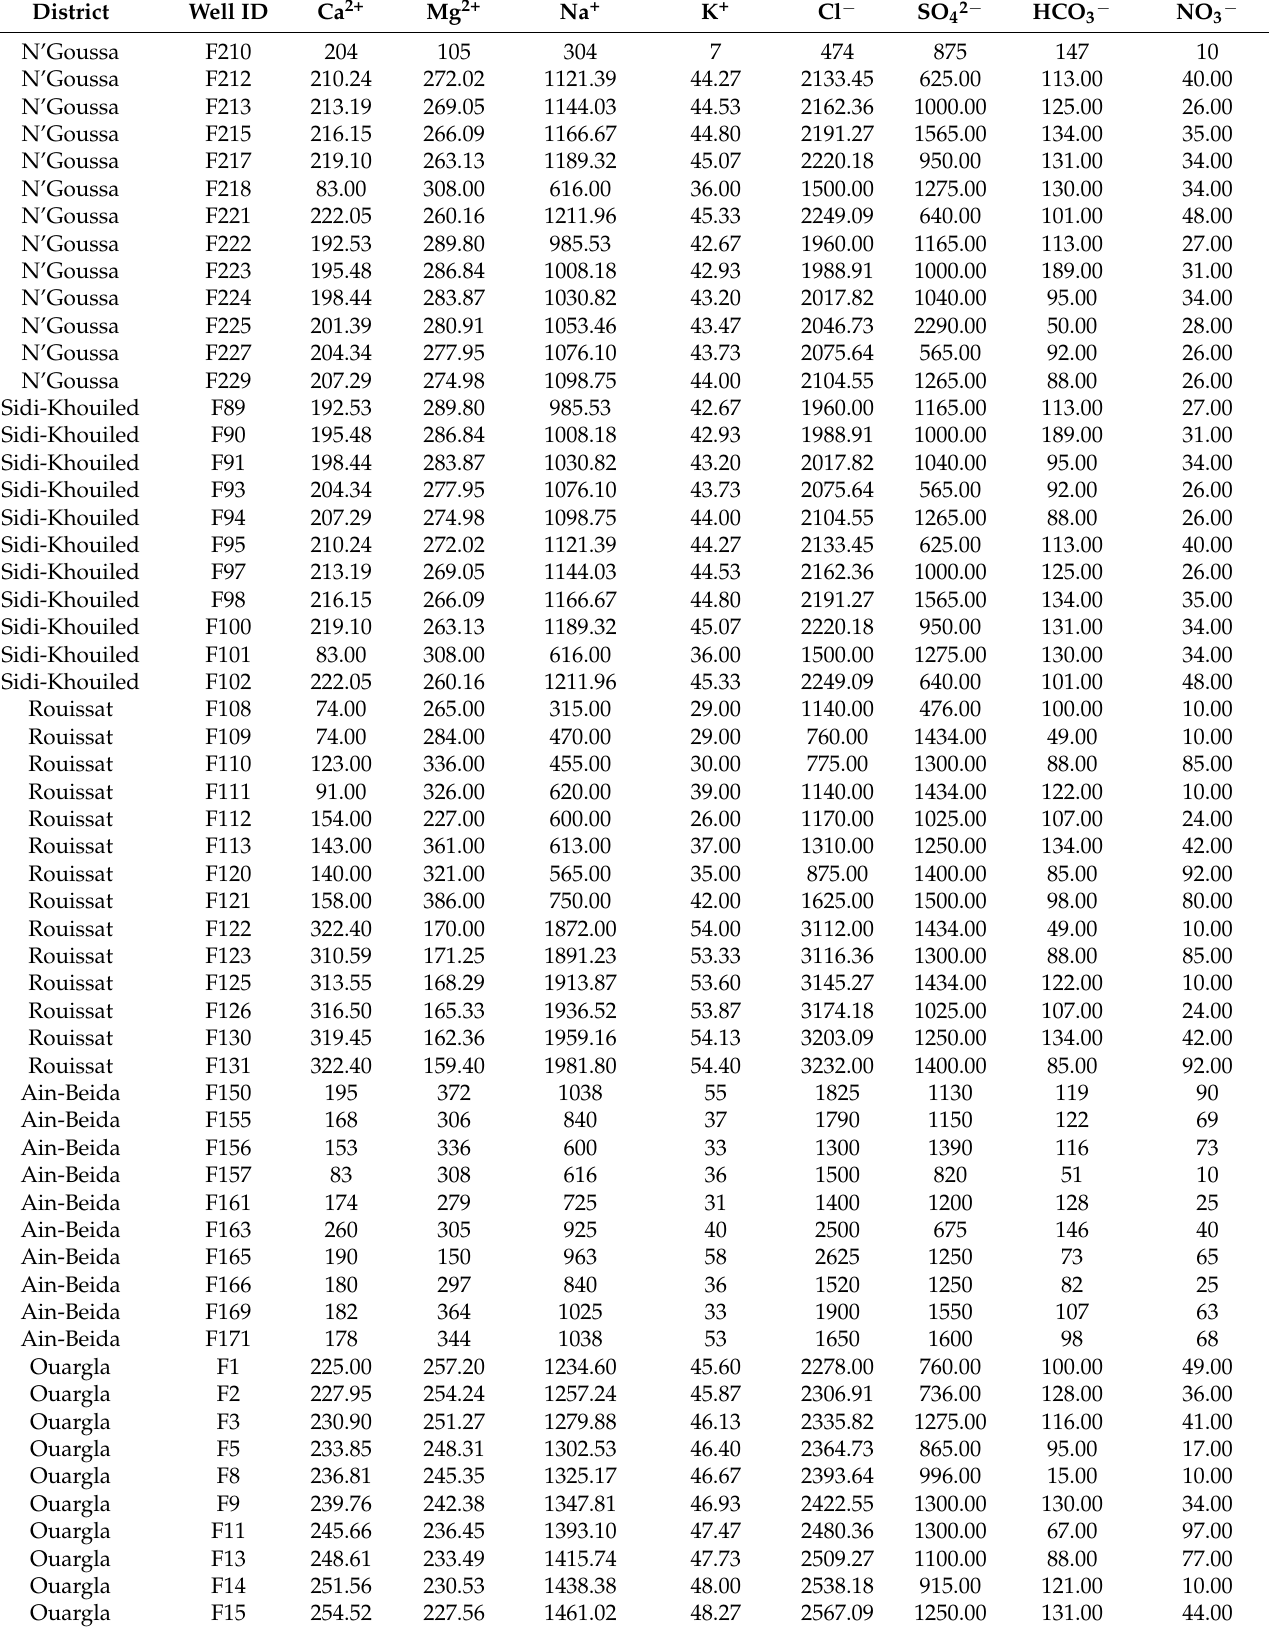
Table A2. Ion concentrations of analyzed